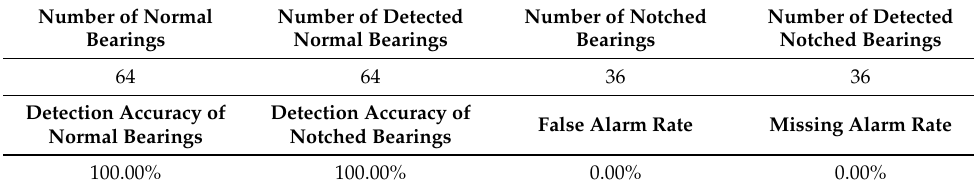
Table 2. Detection results of